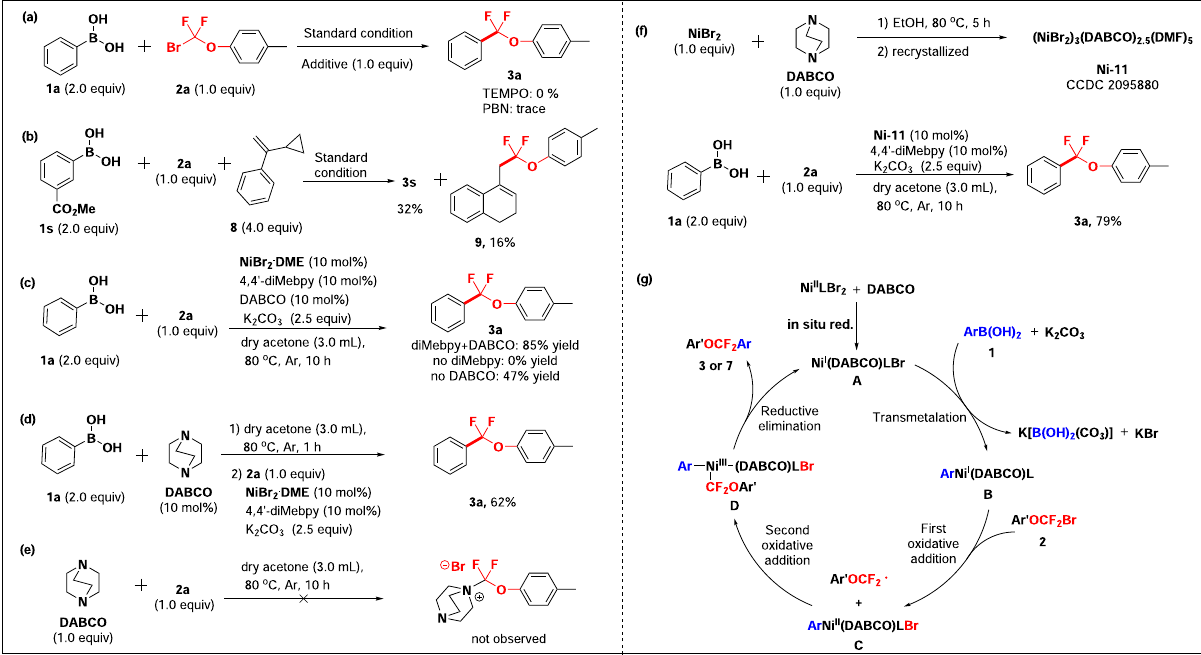
Fig. 4 Mechanistic studies and proposed mechanism. a Radical inhibition experiments. b Radical clock experiments. c The reaction proceeds under NiBr 2 . DME, 4,4 ’ -diMeby and DABCO. d The reaction proceeds through pretreatment of DABCO and phenylboronic acid 1a . e Salt-forming experiment between DABCO and aryloxydi fl uoromethyl bromides 2a . f The reaction proceeds under Ni(II) complexes[(NiBr 2 ) 3 (DABCO) 2.5 (DMF) 5 ] and 4,4 ’ -diMeby. g Proposed catalytic